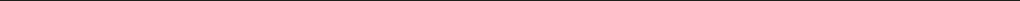
All images are representative. For all bar graphs , data are the mean ± SEM, * P < 0.05 and ** P < 0.01 (one-way ANOVA with Tukey ’ s post hoc